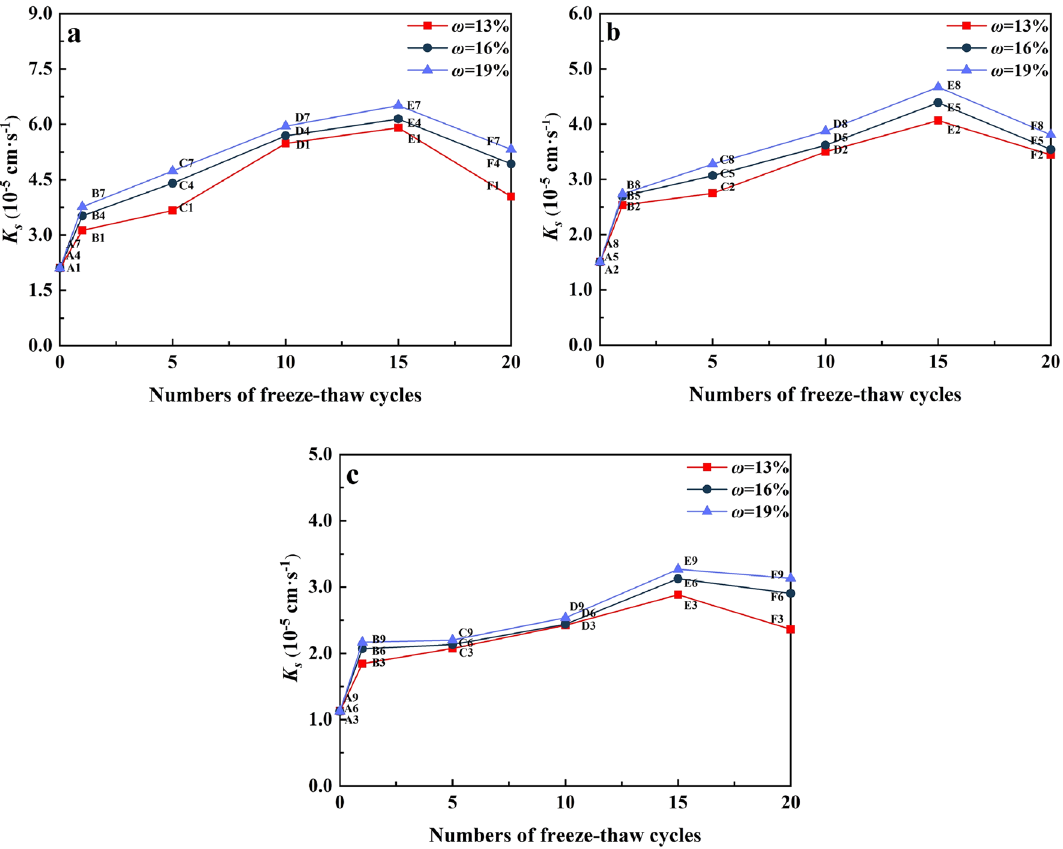
Figure 7. The changes of K s of water-bearing remolded soils at the study site in the floodplain of southwestern Shandong Province caused by the changes of F–T cycles: ( a ) ρ d = 1.48 g cm −3 , ( b ) ρ d = 1.53 g cm −3 and ( c ) ρ d = 1.58 g cm −3